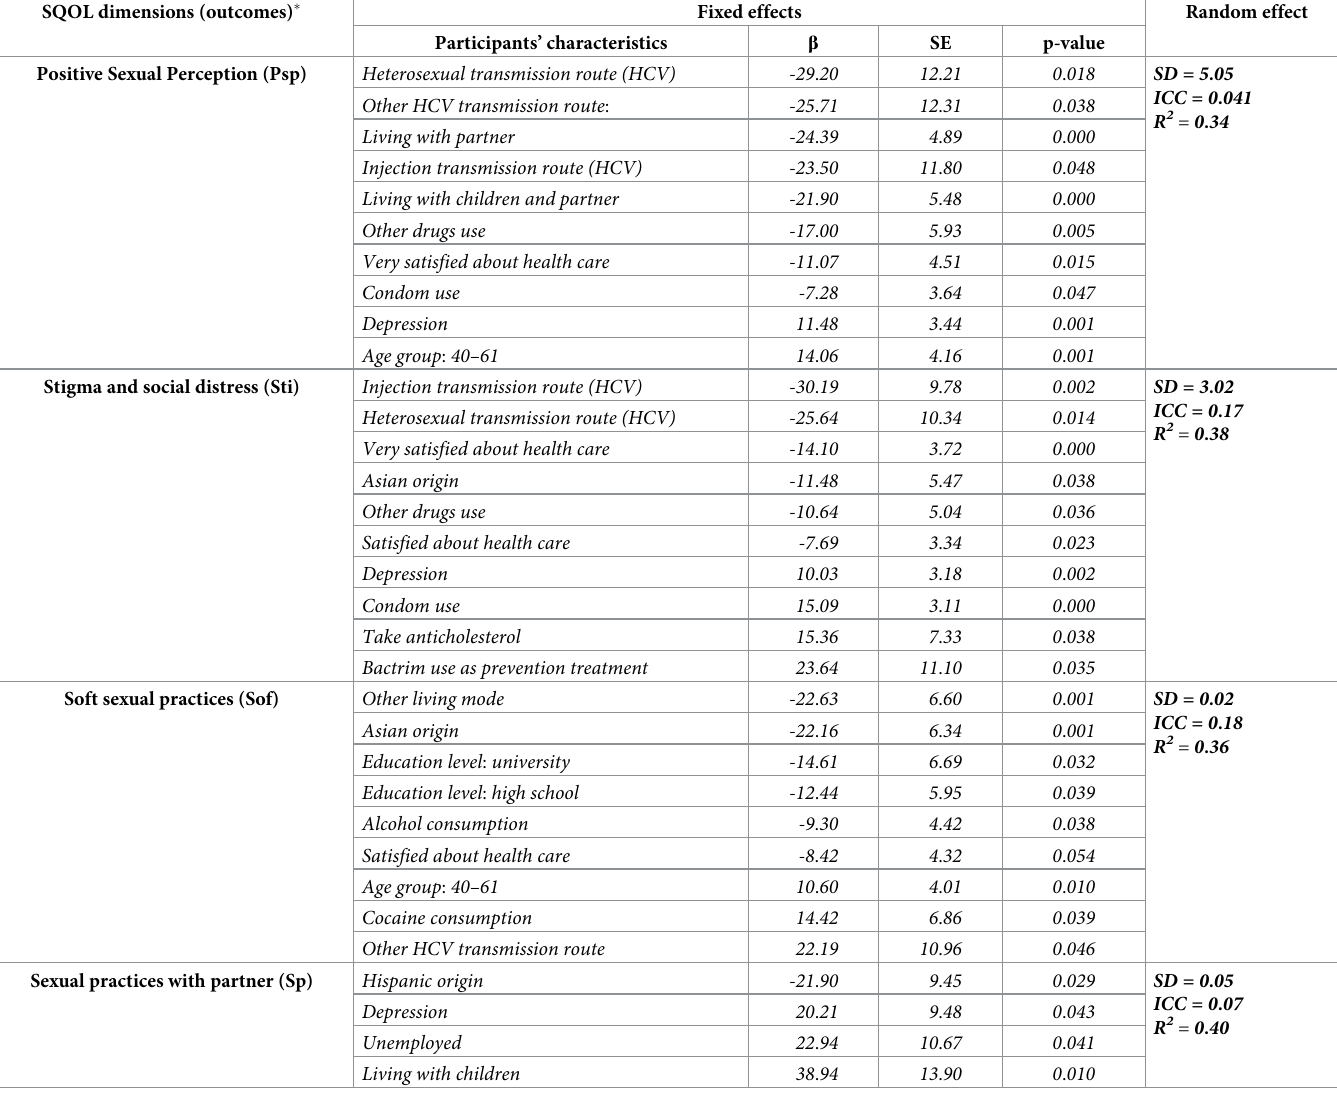
Table 4. Factors associated with PROQOL-Sex Life dimensions among WHCV (multivariable linear mixed effects regression). SQOL dimensions (outcomes)